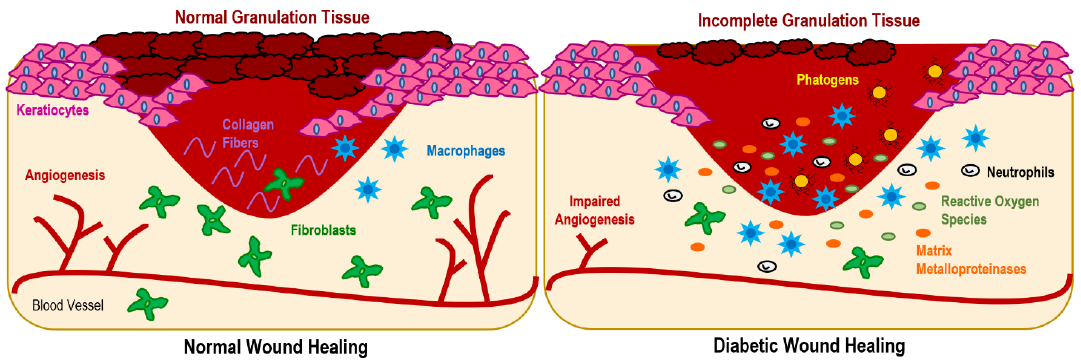
Figure 2. Diabetic wounds are characterized by impaired angiogenesis, excessive inflammation (increase in macrophage recruitment), augmented production of matrix metalloproteinases, hypoxia and hyperglycemia, which is associated with a raise of the reactive oxygen species expression that prevents the formation of healthy tissue. All these factors condition granulation tissue formation, maintaining the wound in an inflammatory state, which is also exacerbated by installation of pathogenic microbes.